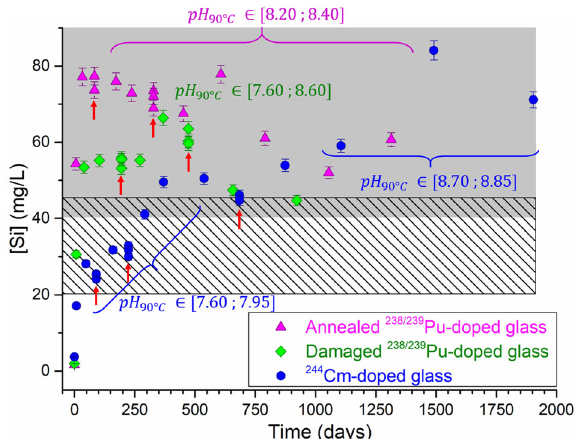
Fig. 1 Si releases and pH evolution versus time for doped glasses leaching tests. Total silicon concentration versus time for annealed and damaged 238/239 Pu-doped glass leaching tests (pink triangles and green diamonds, respectively) and 244 Cm-doped glass leaching test (blue circles). pH ranges at 90 °C, calculated from measured pH at 25 °C, are detailed for each test in order of magnitude. The gray and hatched areas correspond to saturation values of SON68 glass with respect to orthosilicic acid (H 4 SiO 4 ), based, respectively, on Gin et al. 41 or on Jegou et al. 50 for a pH 90°C ≤ 8.97. Red arrows indicate sampling with fi ltration and ultra fi ltration to check for colloids. Errors bars are of